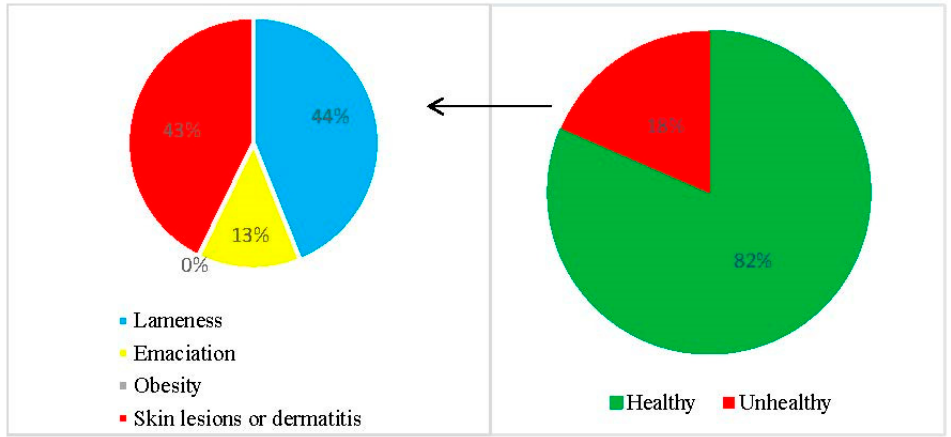
Figure 4. Health status of FRDs during the survey based on visual observation (direct observation during the survey or from reviewing photographs).